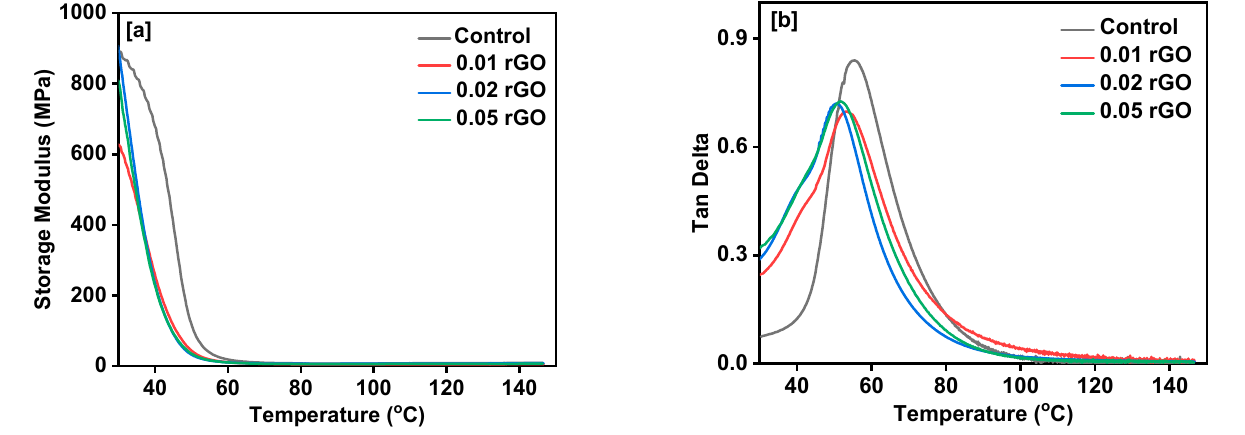
Figure 8. Dynamic mechanical properties of rGO-based films as a function of temperature: ( a ) storage modulus and ( b ) tan delta.